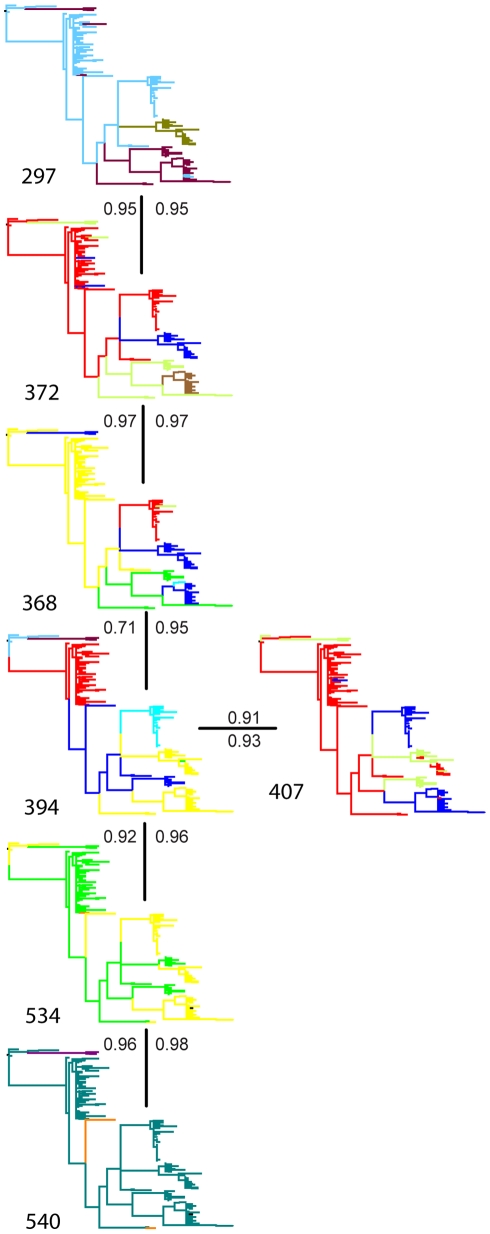
Sites identified by Bayesian graphical models to co-evolve.Amino acid sites 297, 372, 368, 394, 407, 534 and 540 of the GII.4 capsid protein were depicted as trees showing different amino acids in different colors. Each connection is associated with posterior probabilities (P) for single (above or left) or two (below or right) dependencies.